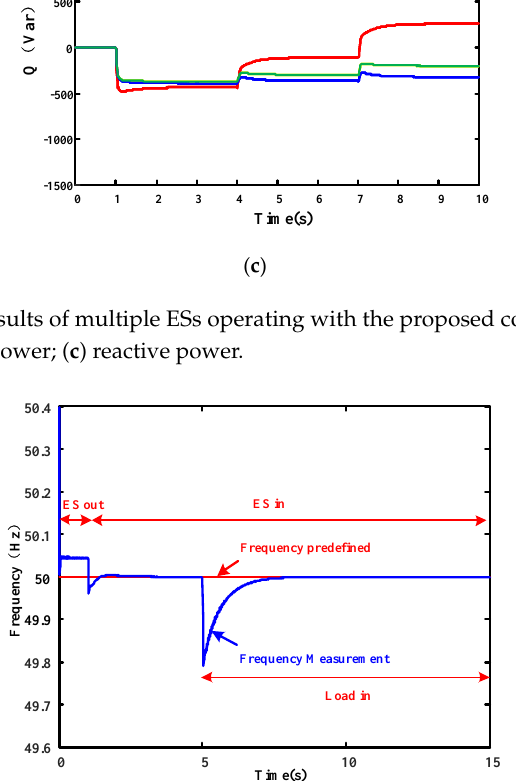
Figure 14. Simulation results of frequency responses with three ESs under the proposed control.